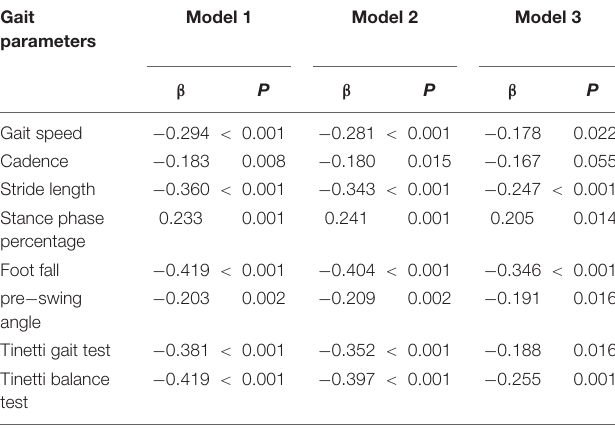
TABLE 4 | Results of multiple linear regression analysis between gait performance and